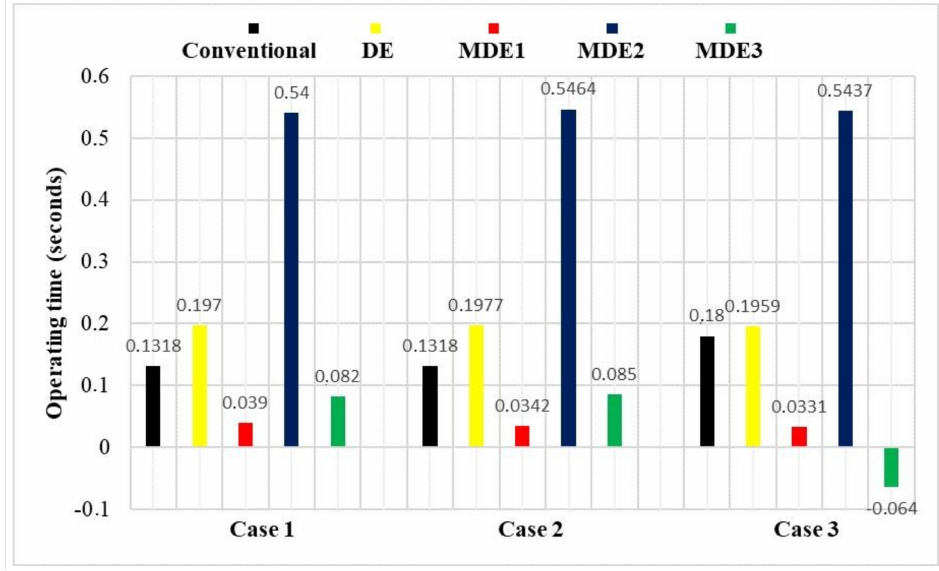
Figure 12. Recloser operating time for the different settings.